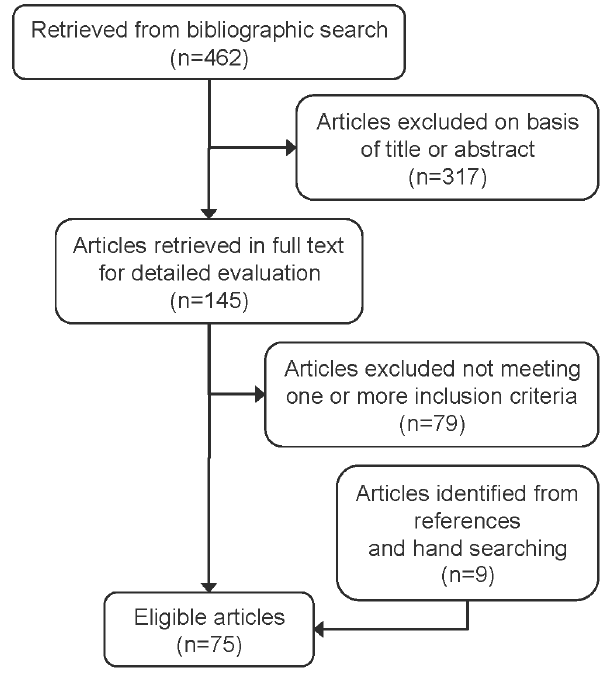
Figure 1. Flow diagram of study selection. process